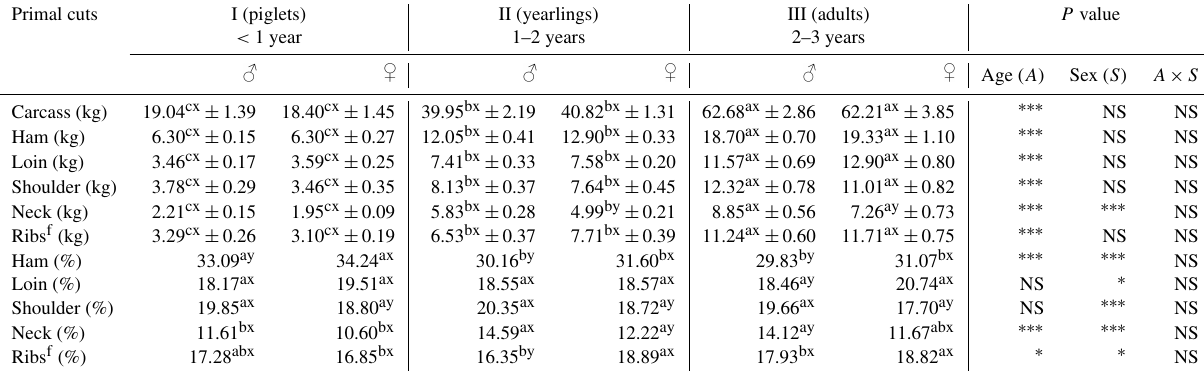
Table 1. Weight and percentage content (with respect to the carcass weight) of primal cuts in wild boar carcasses (mean ± SE). Primal